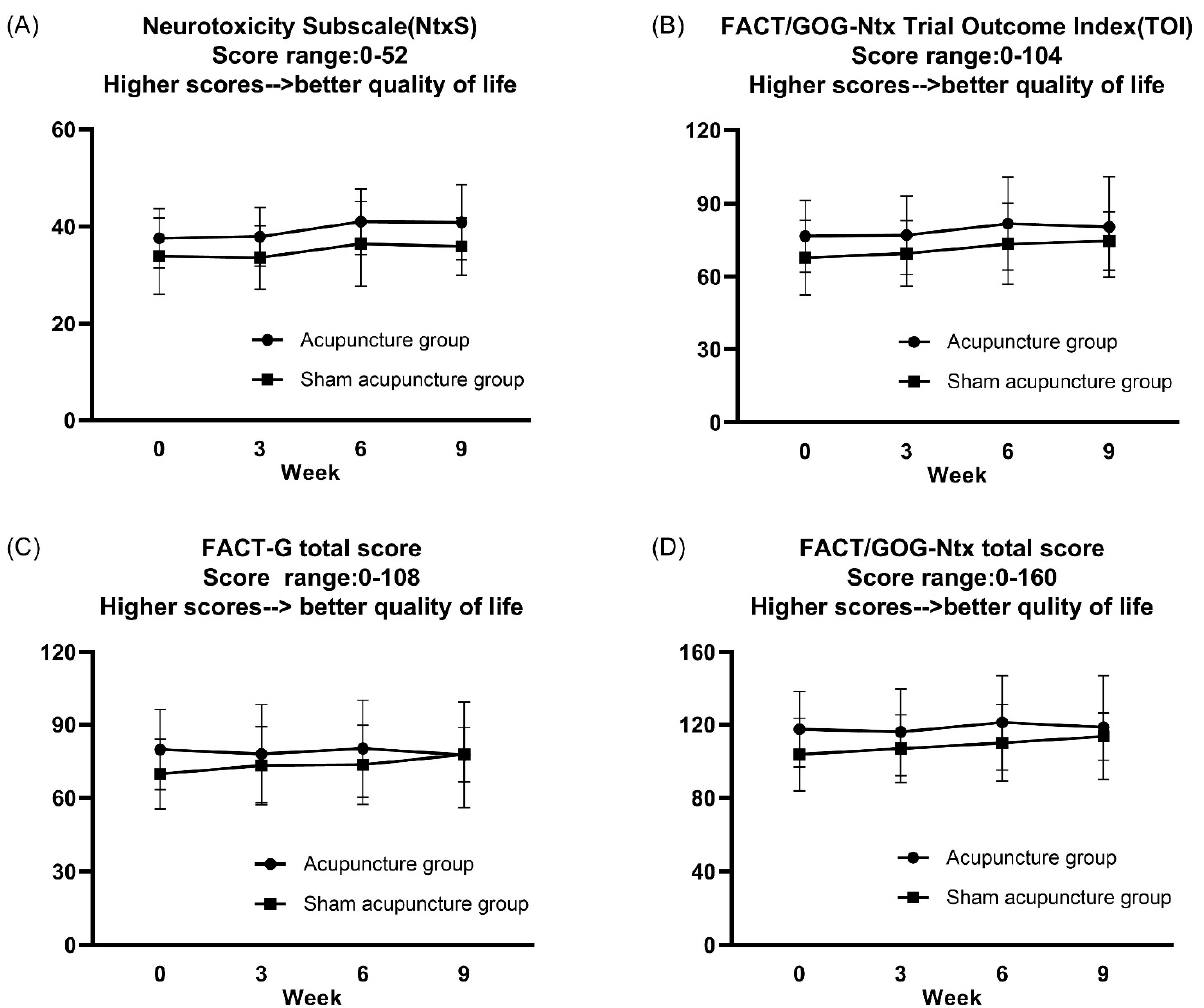
Figure 5. The participants’ FACT/GOG-Ntx scale before (baseline value), and at the 3rd, 6th, and 9th weeks. ( A ) Patient- reported outcomes in the neurotoxicity subscale, which evaluates the degree of neurotoxicity. ( B ) Patient-reported outcomes in the FACT/GOG-Ntx trial outcome index (TOI), which contains the neurotoxicity subscale, physical and functional well-being in quality of life. ( C ) Patient-reported outcomes in the FACT/GOG-G total score, which contains physical, social/family, emotional, and functional well-being in quality of life. ( D ) Patient-reported outcomes in the FACT/GOG-Ntx total score. Data are expressed as mean ± standard error of the mean (SEM). The two-way ANOVA with repeated measures revealed that there were neither significant interaction effects between time and group factors nor significant main effects of time and group